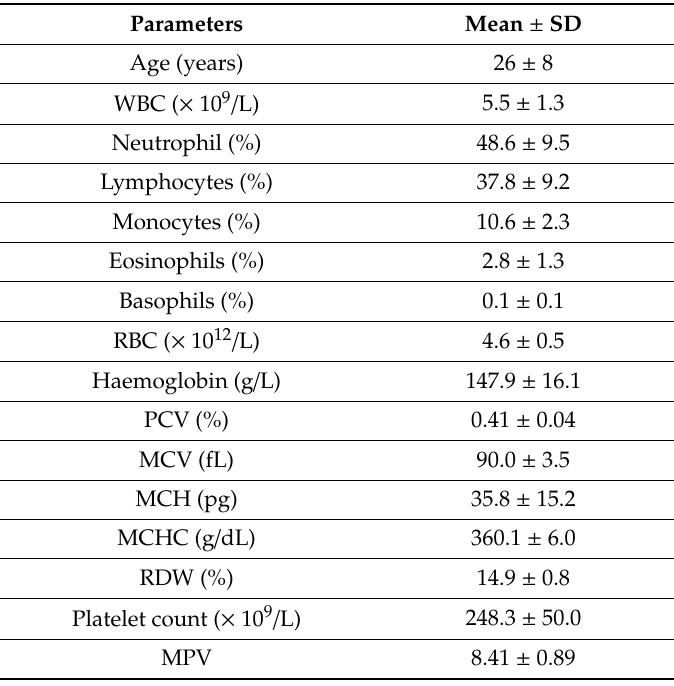
Table 1. Baseline full blood counts of